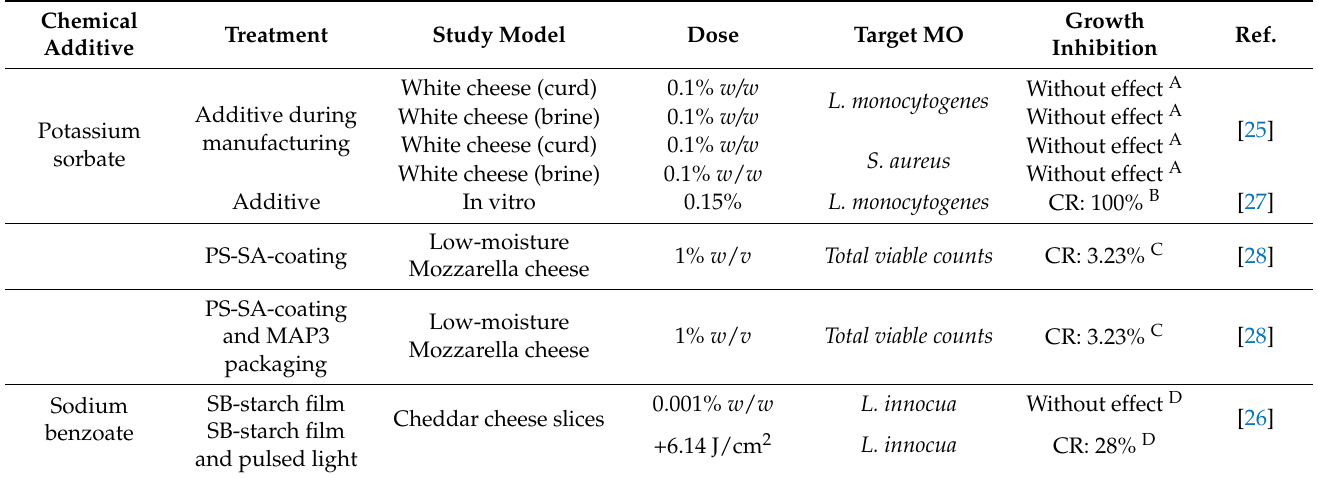
Table 1. Traditional chemical additives to preserving